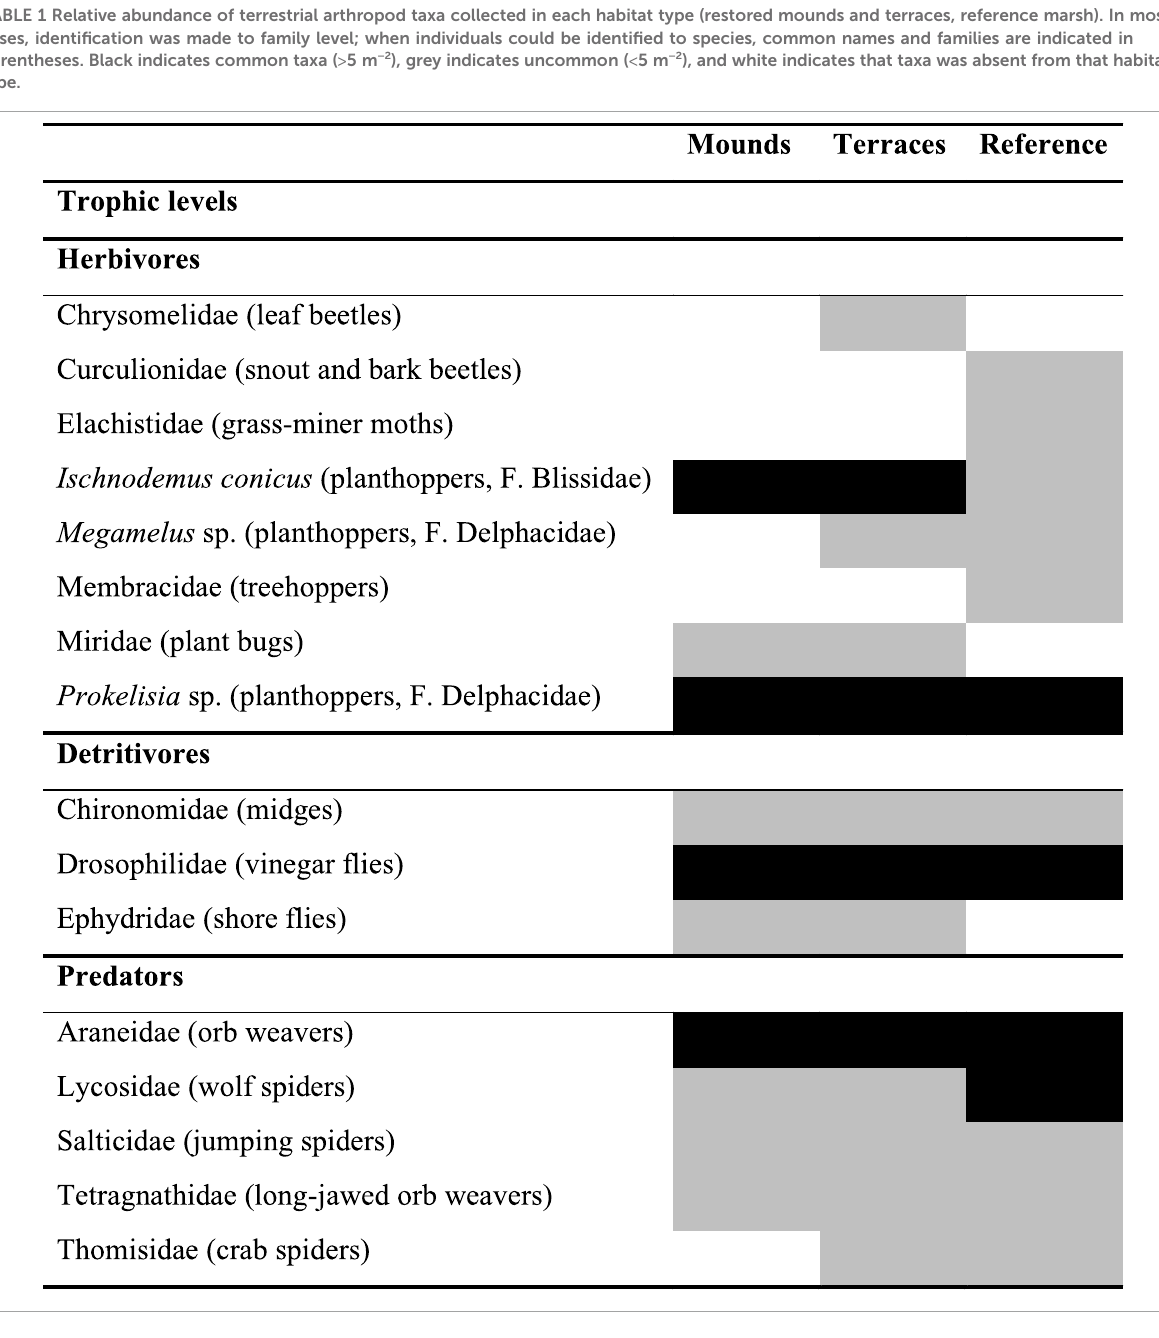
TABLE 1 Relative abundance of terrestrial arthropod taxa collected in each habitat type (restored mounds and terraces, reference marsh). In most cases, identi fi cation was made to family level; when individuals could be identi fi ed to species, common names and families are indicated